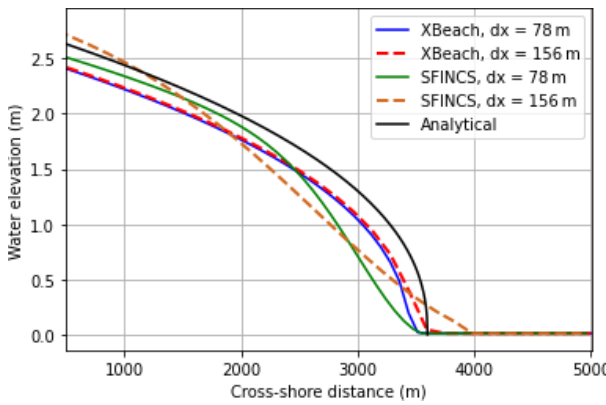
Figure 4. Comparing the final water elevation from using SFINCS and XBeach at d x = 78m and d x = 156m (corresponding to 64 and 32 elements in the x direction respectively) with the analyti- cal result for the non-breaking wave test case. A Manning friction coefficient of 0.0364sm − 1 / 3 is used in all